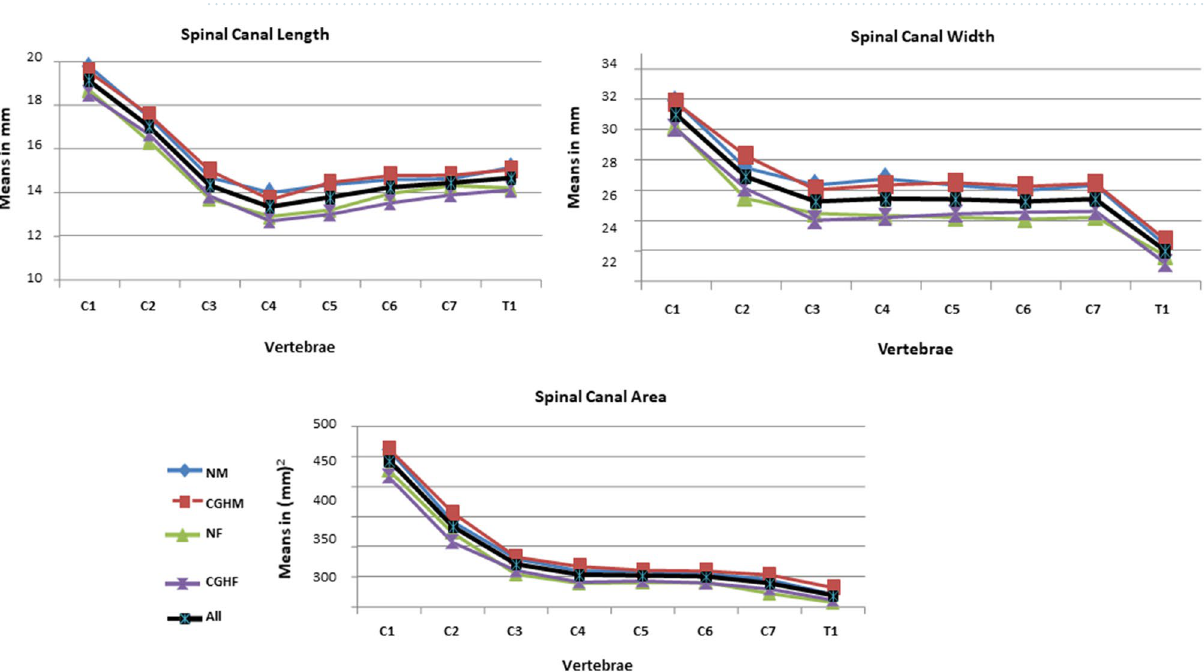
Figure 5. Spinal canal shape variation along the cervical spine. NM normal males, CEHM cervicogenic headaches males, NF Normal females, CEHF cervicogenic headaches females, All all individuals